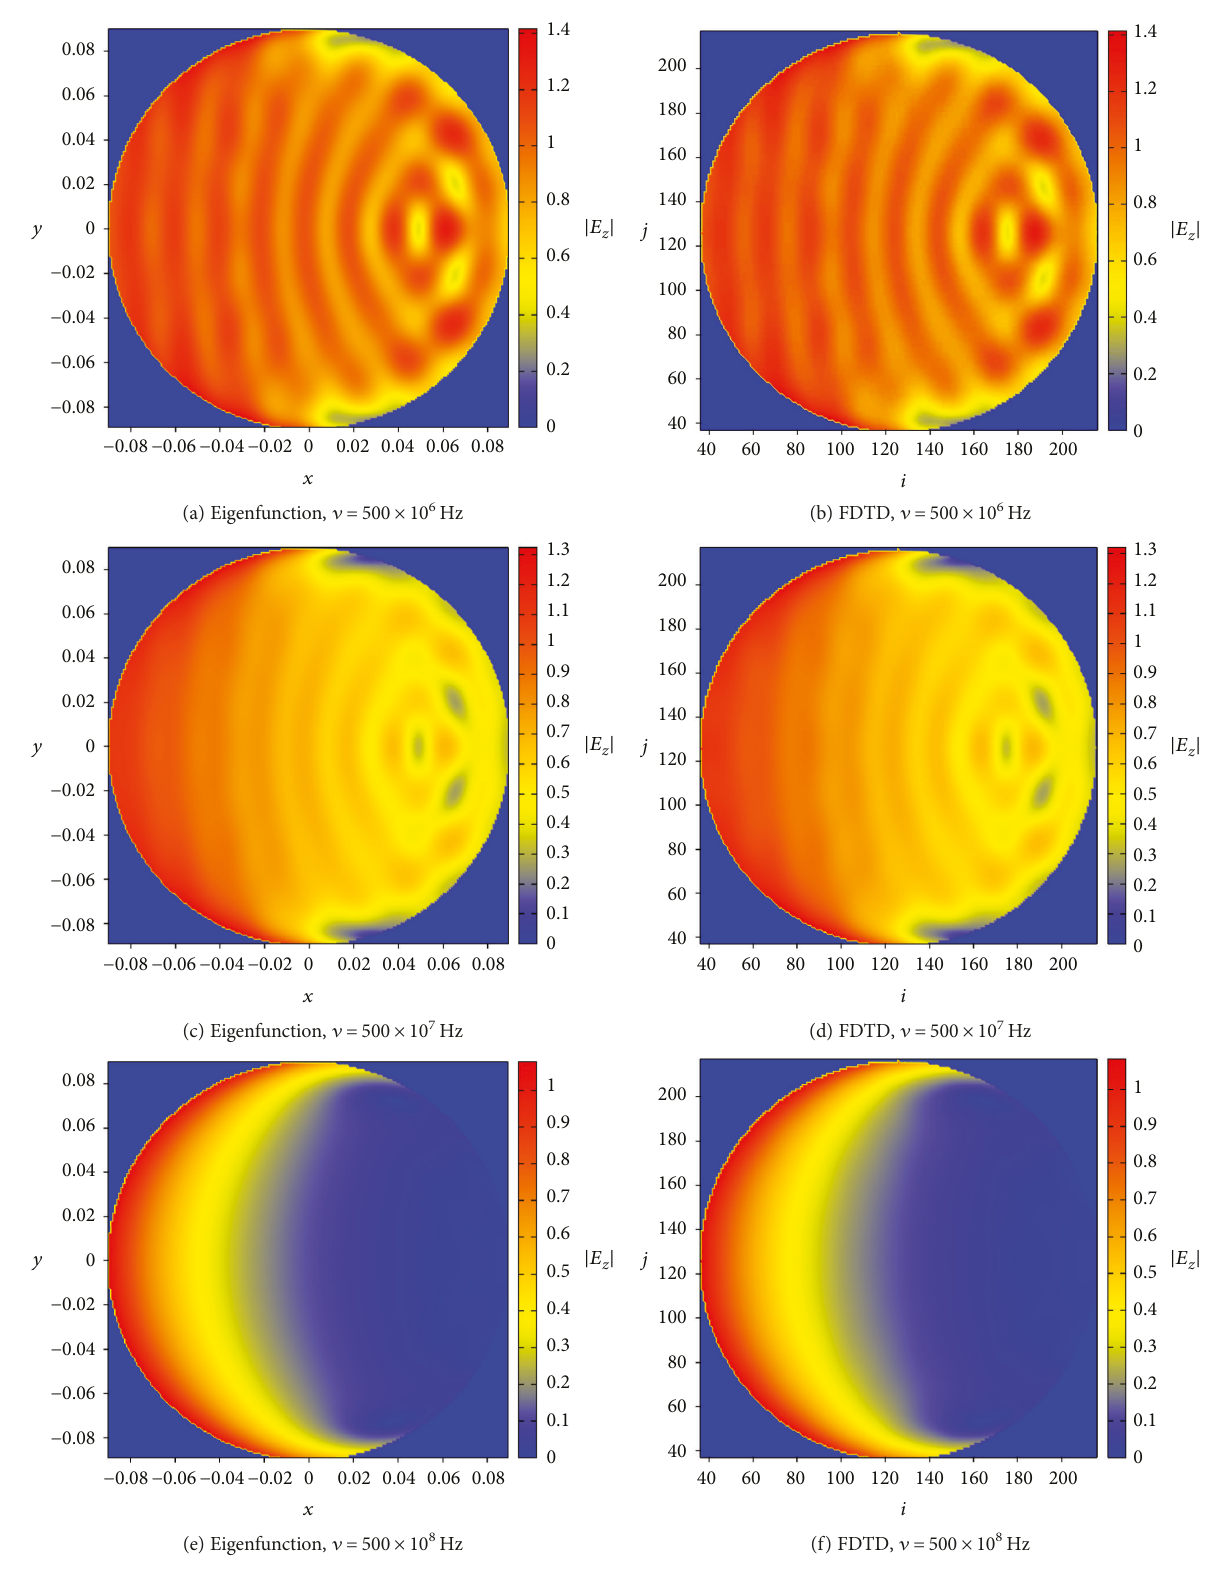
Figure 8: Comparison between the magnitude of the electric fi eld, in volts/meter, within the cylinder obtained by the eigenfunction method and the FDTD simulation for di ff erent collision frequencies; incident wave frequency is set to f =5 × 10 17 m − 3 n 0